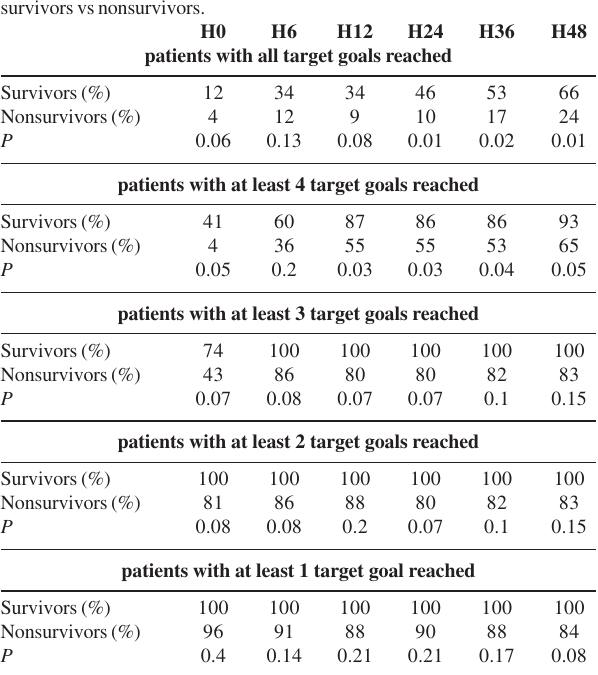
patients with at least 1 target goal